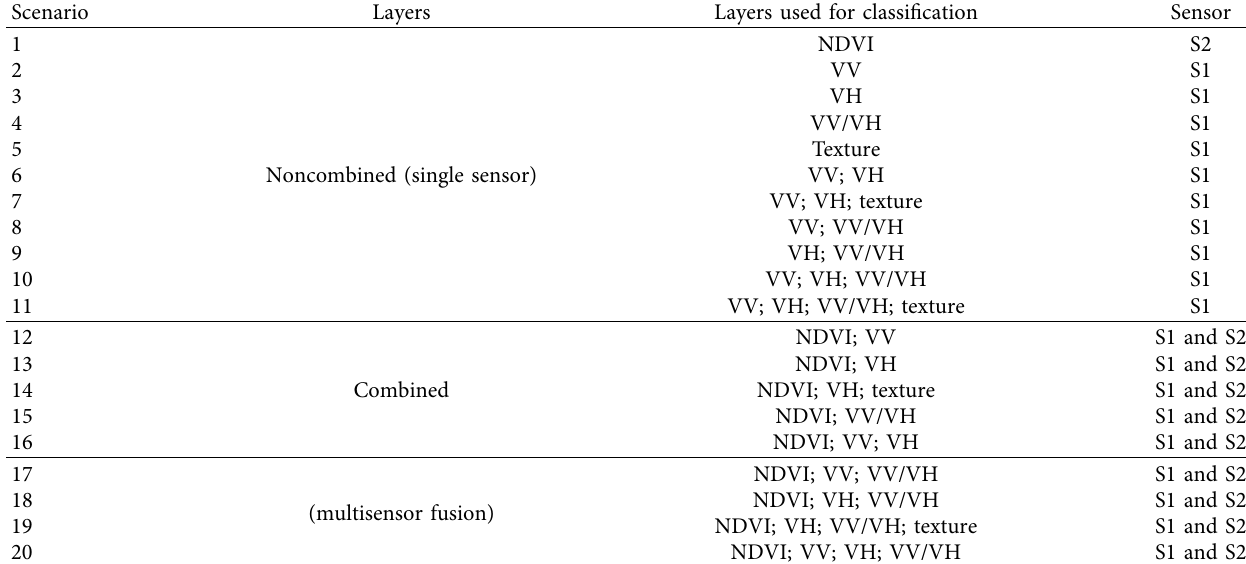
Table 2: Different scenarios (noncombined and combined) from multisensor bands to